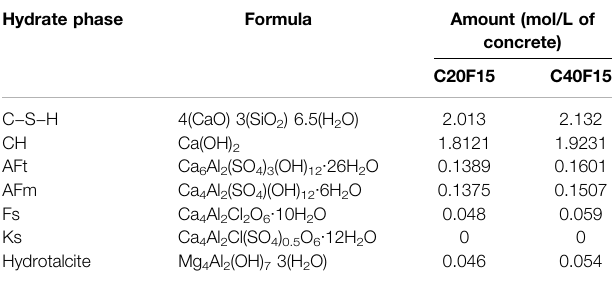
TABLE 6 | Hydrated cement compounds of CACs with C20F15 and